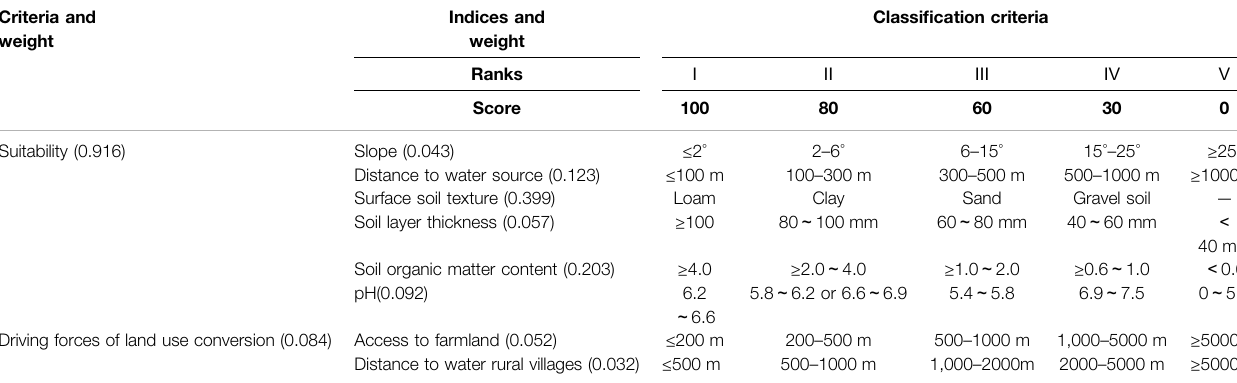
TABLE 3 | Multicriteria evaluation system for cultivated land con fl ict. Criteria and